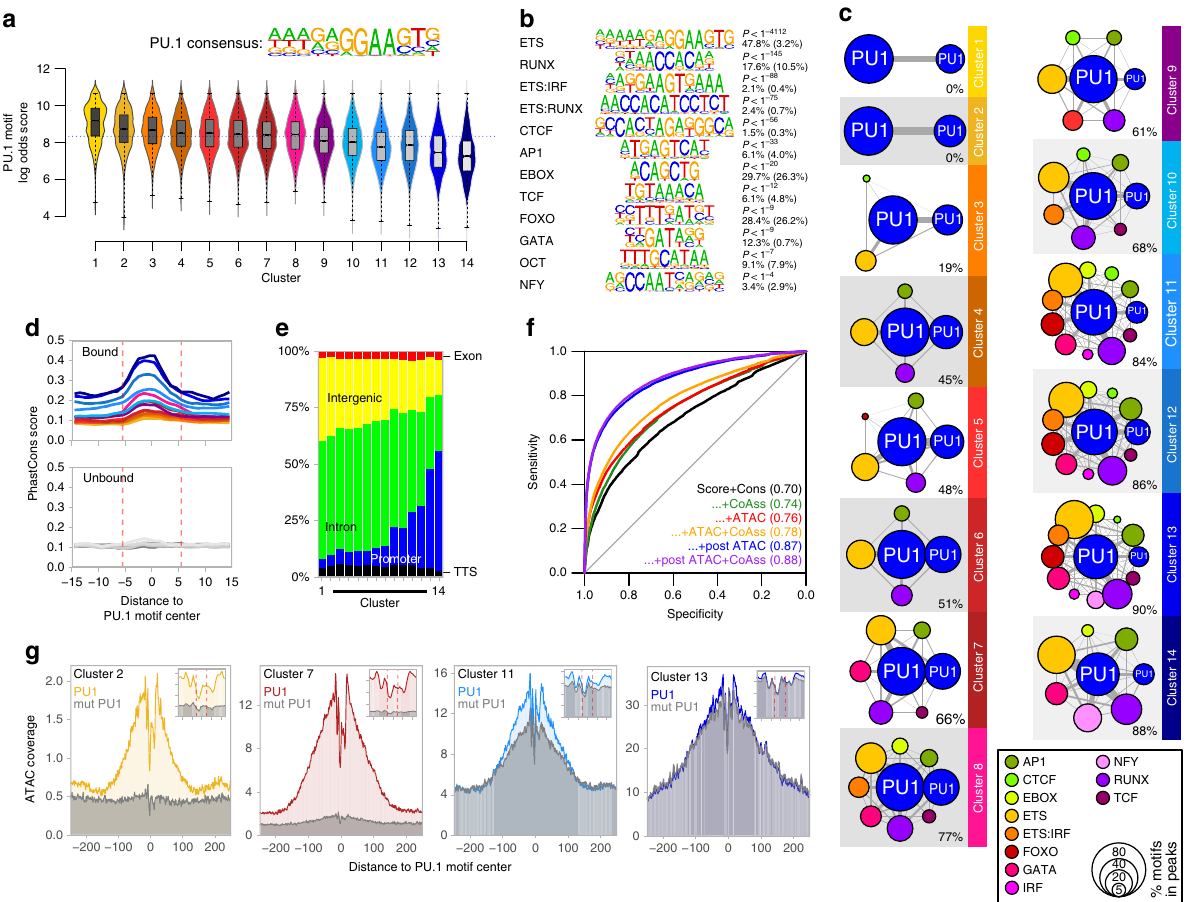
Fig. 4 Genomic features of PU.1-induced accessible sites. a The PU.1 motif log odds score distribution of the consensus MAC PU.1 motif, generated earlier, is shown for each cluster. The median of the speci fi c distribution across all clusters is depicted inside the bean with a conventional boxplot. b De novo-derived co-associated motifs enriched across ATAC-seq-derived PU.1 peak clusters. The best motifs corresponding to known factor families derived from individual clusters are shown. Signi fi cance of motif enrichment (hypergeometric test) and the fraction of motifs in peaks (background values are given in parenthesis) correspond to their distribution across all PU.1 peak regions. c Motif co-enrichment networks for individual clusters are shown. The size of each node represents the motif enrichment (fraction of peaks) and co-associated TF motifs (PU.1 masked) are indicated by coloring. The second PU.1 node corresponds to the fraction of peaks containing at least two PU.1 motifs. Edge thickness indicates the frequency of motif co-association within the PU.1 peak. The fraction of PU.1 peaks overlapping with co-associated (PU.1 masked) TF motifs is given below each network. d Evolutionary conservation of the PU.1 motif across the K-means clusters, color coded as in Fig. 3 as illustrated by the PhastCons score. Corresponding sequence-matched random control sets of non-bound motifs are shown in the bottom histogram (in dark gray to light gray). e Genome ontology analysis across the K-means clusters is shown in a stacked bar chart. The association with the individual regions is given as the fraction of peaks in each cluster. f Predictability of PU.1 binding from motif score, conservation score, nearby presence of co-associated motifs, and chromatin accessibility before and after PU.1 induction. Shown are ROC curves of logistic models with different sets of predictors (AUC in parentheses), trained and evaluated on separate subsets of the data. g Representative ATAC-seq footprints across motif-centered, cluster-associated peaks (as indicated by coloring). Corresponding footprints of control cells (mutPU.1) are shown in gray. Smaller histograms in the upper right corner zoom into the central part of the main graph. The position of the PU.1 motif is indicated by two vertical dashed lines. a – g Source data are provided as a Source Data fi